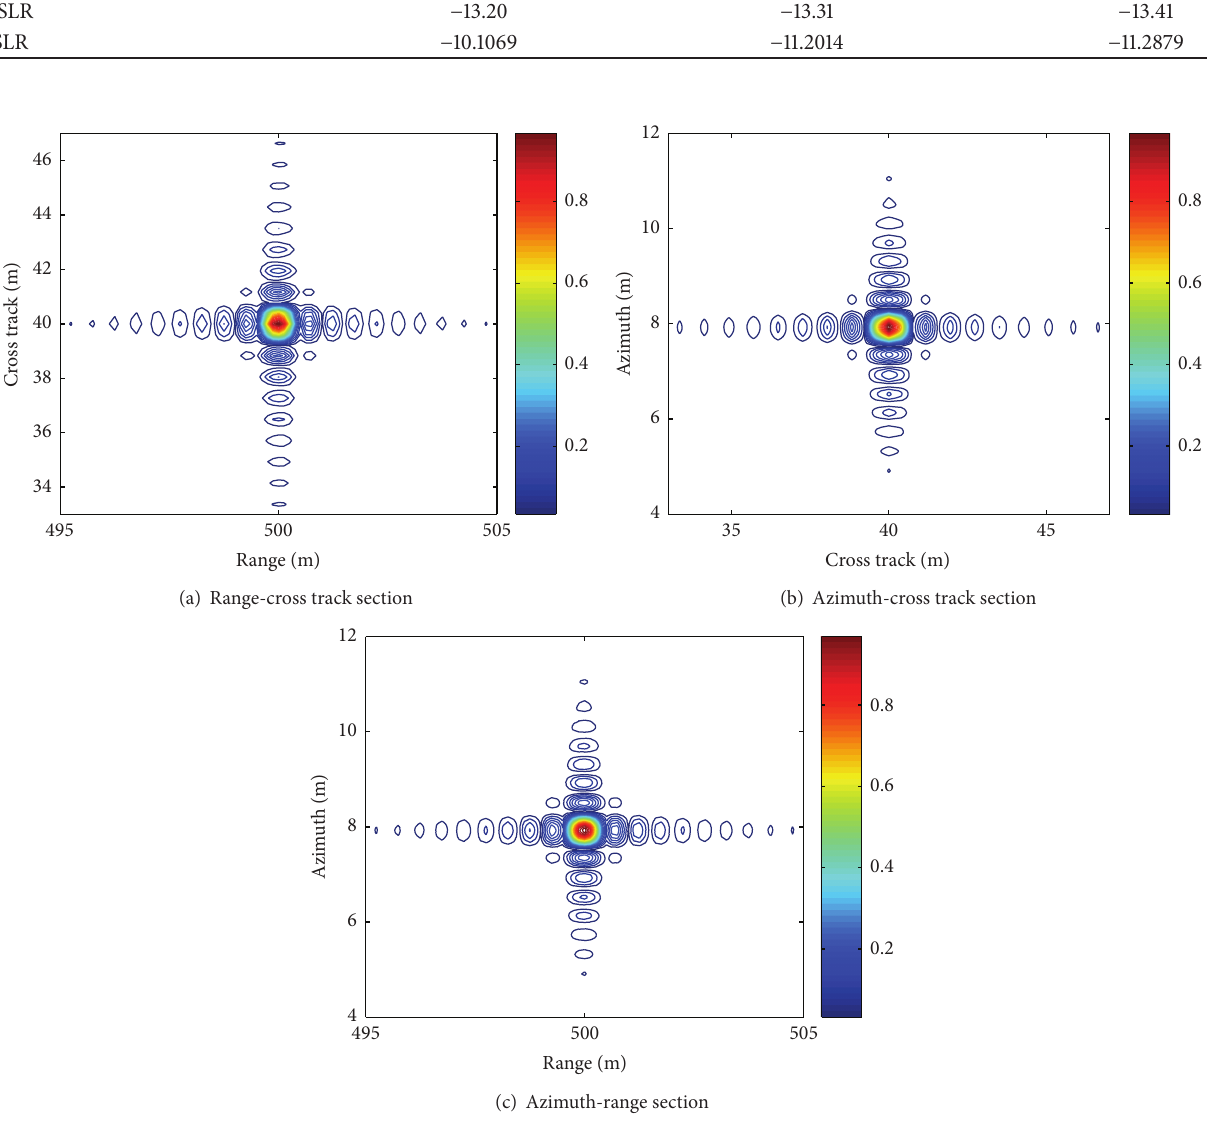
Figure 7: 2D contour plots of the extracted point